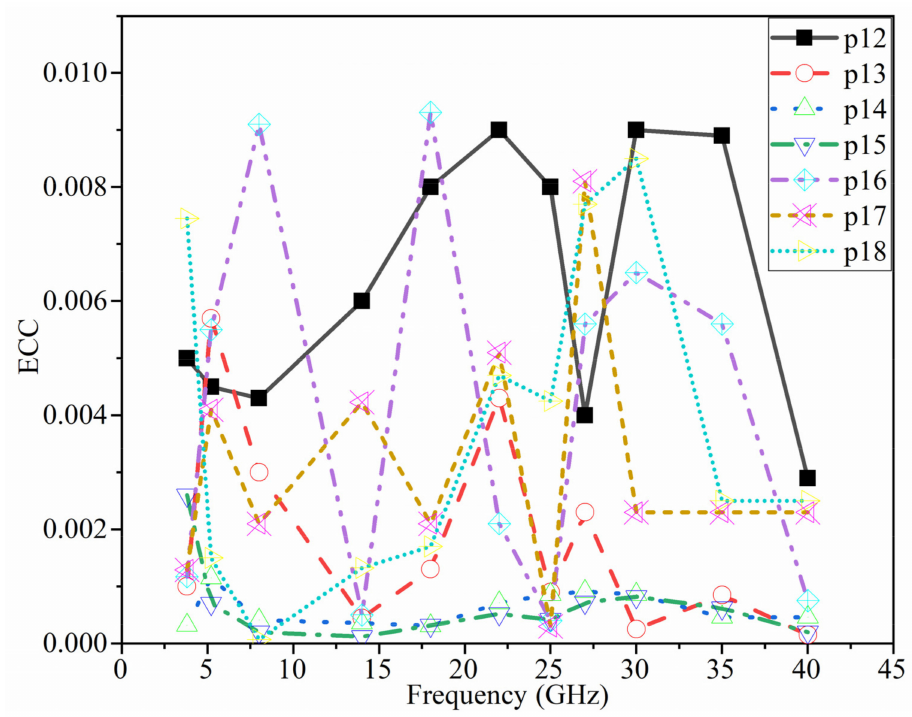
Figure 22. ECC alteration between port 1 and other seven ports (e.g., P 12 : ECC between Port 1 and Port